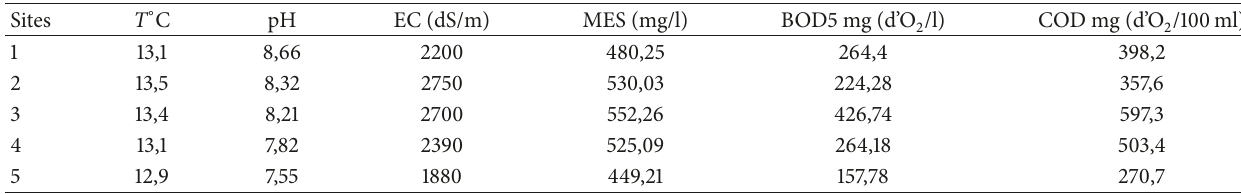
Table 1: Average values of physicochemical characteristics of El Gourzi effluent wastewaters in 5 different upstream to downstream points [15].